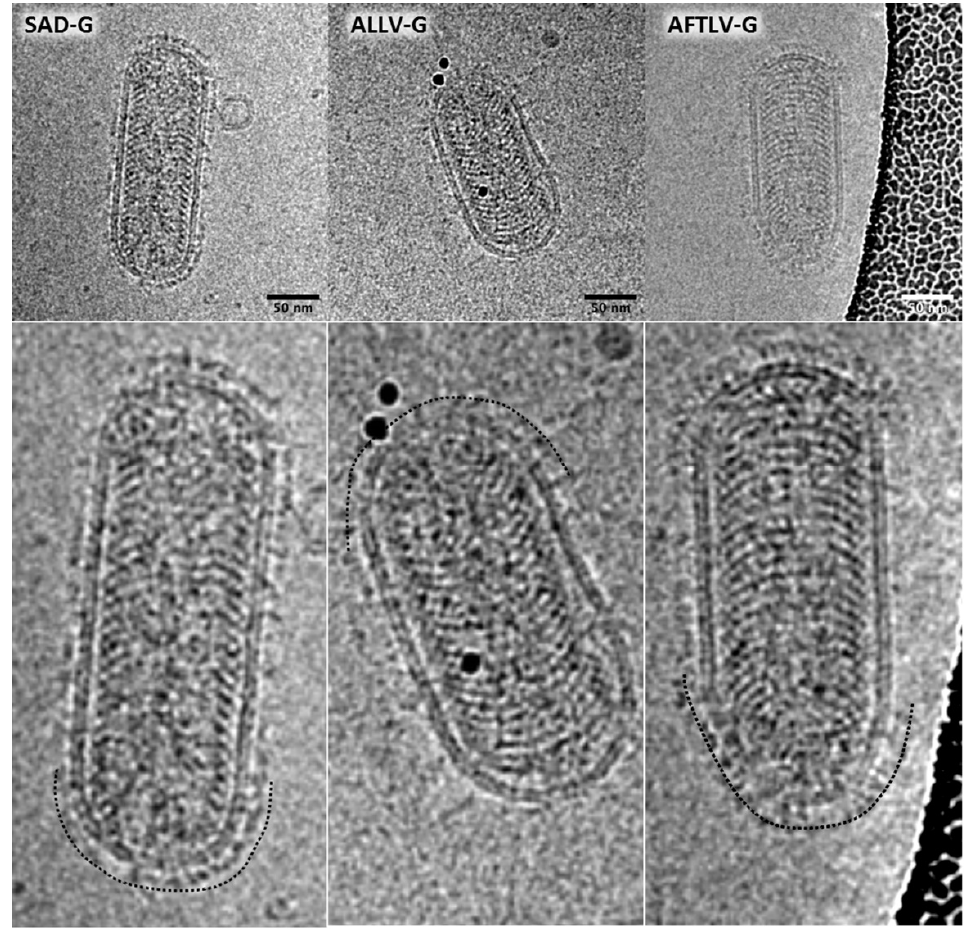
Figure 2. Morphology of ALLV and AFTL G virus particles. RABV pp containing SAD, ALLV, and ATFLV G proteins were analyzed by cryoEM. The original SAD G layer (left) showed a homogenous G protein height of about 8 nm (as indicated by the black checkered line in the detail image), whereas AFTL G protein densities were of a longer and thinner appearance. The coverage of particles with ALLV G protein was poor, and surface glycoprotein densities looked heterogeneous.